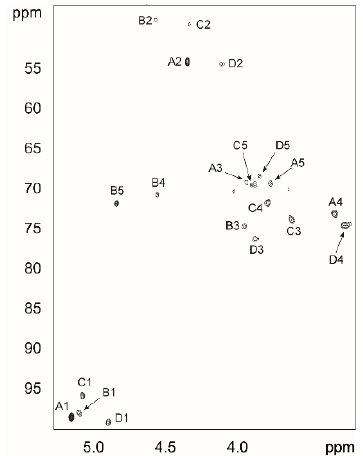
Figure 2. Part of the HSQC spectrum of the O-specific polysaccharide of the LPS from P. shigelloides O24. The inset shows the anomeric region of the spectrum. The uppercase letters refer to designation of sugar